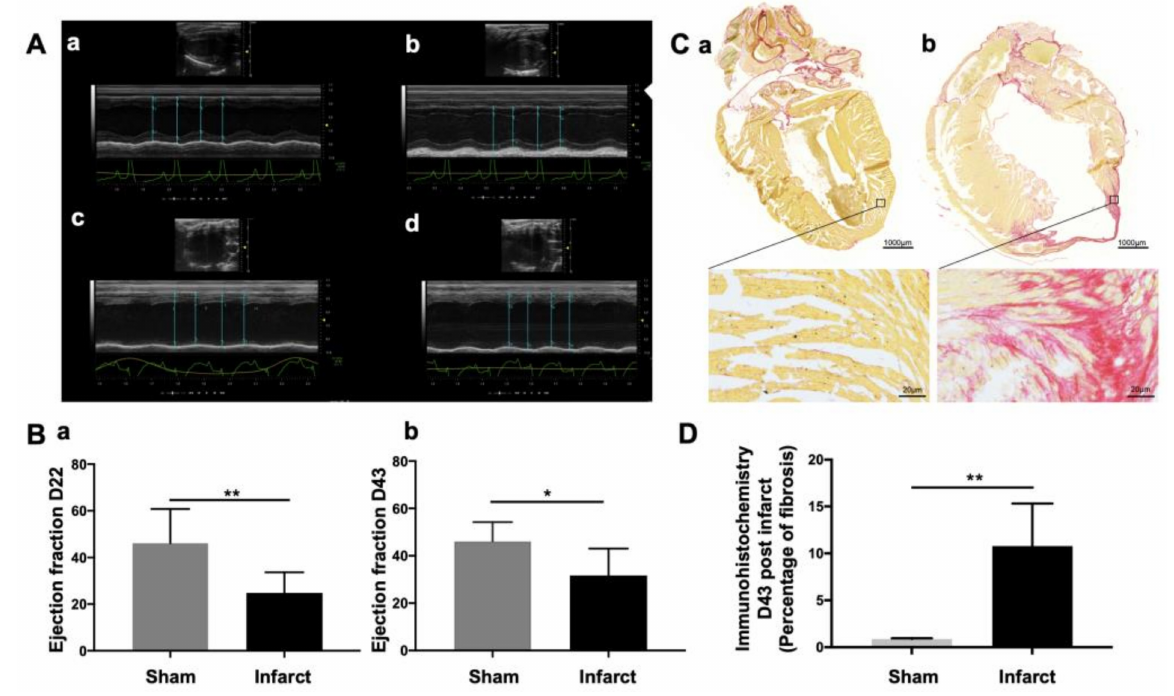
Figure 3. Ultrasound imaging and histological Sirius red staining analysis confirmed that myocardial infarction induced functional impairment. ( A ) Representative images of heart morphology and one-dimensional trace of the above line over time. ( B ) Quantitative analysis of ultrasound signal showed a significant decrease of the ventricular ejection fraction (VEF) compared to sham mice ( a ) (VEF ischemic = 24.8 ± 8.84, n = 7, VEF sham = 46.2 ± 14.5, n = 4; ** p = 0.009 at day 22) and ( b ) (VEF ischemic = 31.7 ± 11.4, n = 7, VEF sham = 46.2 ± 8.08, n = 4; * p = 0.04 at day 43). ( C ) Myocardial fibrosis following myocardial infarction. Histological Sirius red staining was performed 43 days post-surgery. Representative pictures of sham ( a ) and myocardial infarcted ( b ) heart sections showing fibrous tissue is stained red and myocardium is stained yellow. ( D ) Fibrosis quantification expressed as a percentage of fibrosis over the left ventricle showed a significant increased fibrosis in the infarcted heart compare to sham heart (Mean ischemic = 10.79 ± 4.52, n = 7, Mean sham = 0.88 ± 0.07, n = 4; ** p = 0.0061) at day 43